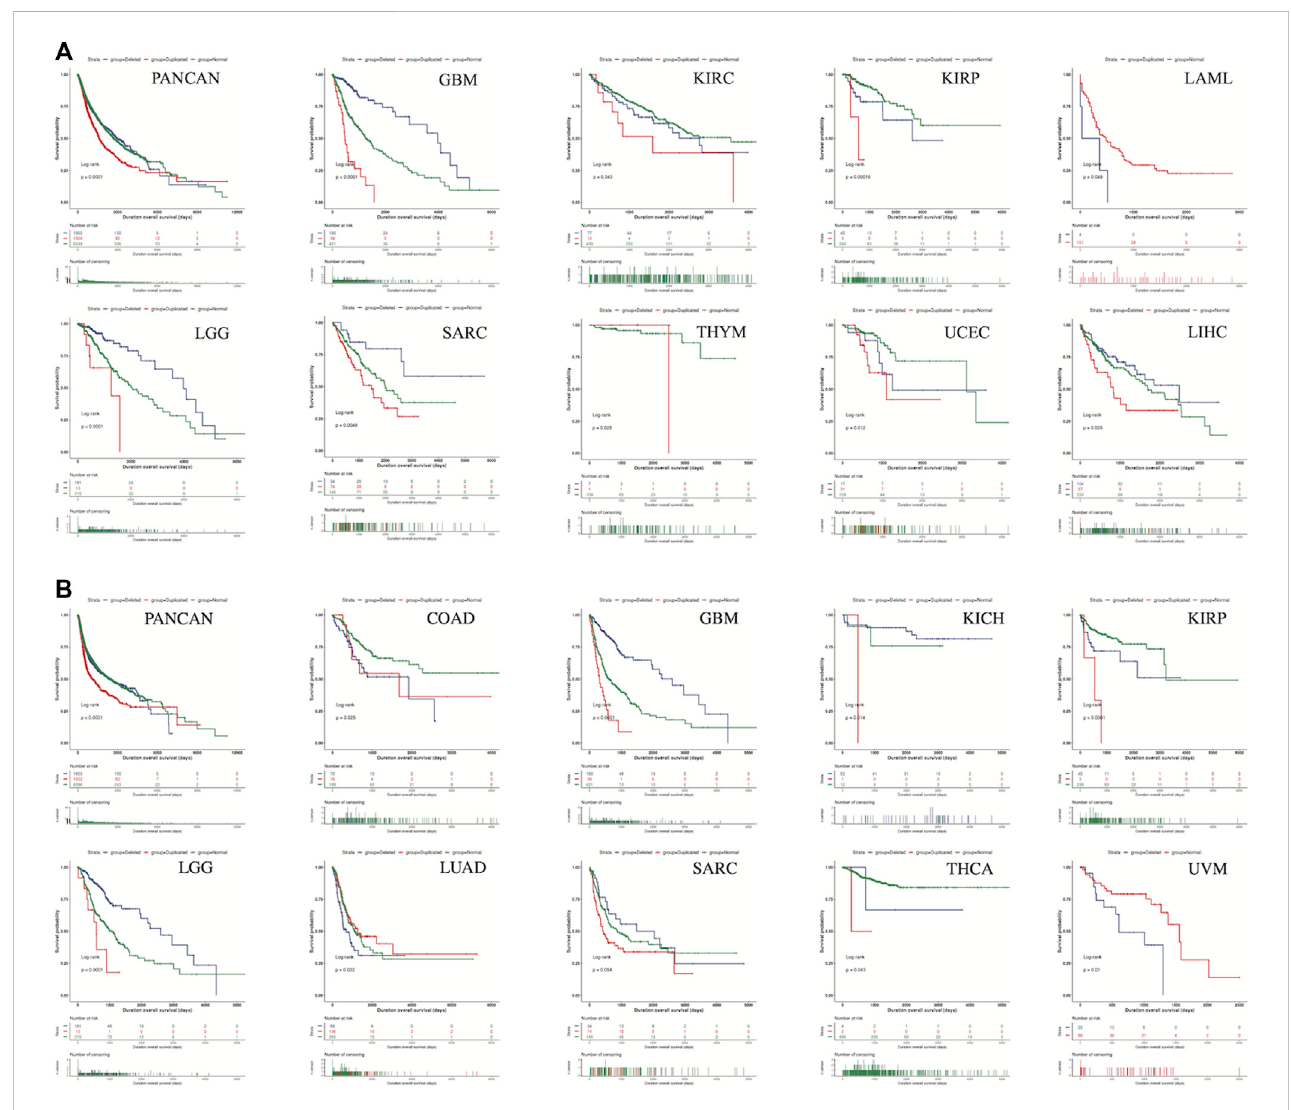
FIGURE 4 The CNA species of SLC2A1 was strongly associated with tumor prognosis in a wide range of cancers (A) The CNA species of SLC2A1 was strongly associated with OS in 10 cancers (B) The CNA species of SLC2A1 was strongly associated with PFS in 10